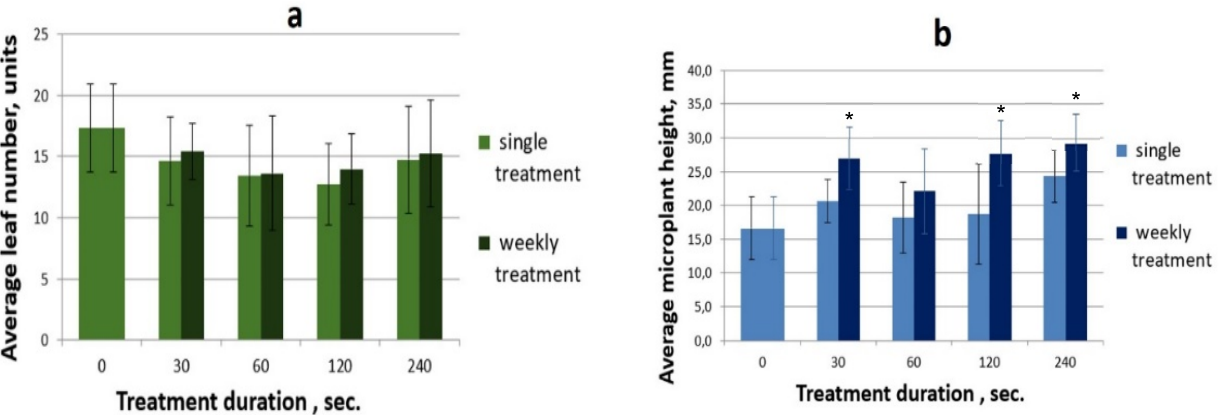
Figure 8. The influence of coherent light treatments on ( a ) the average number of leaves per microshoot and ( b ) the microshoot height of plants cultured on an MS medium containing 0.1 mg L − 1 Epin and 0.5 mg L − 1 IAA. Means ± standard errors at α = 0.05 according to ANOVAs test ( n = 60). *-variants that have significant differences between control treatments (without treatment).